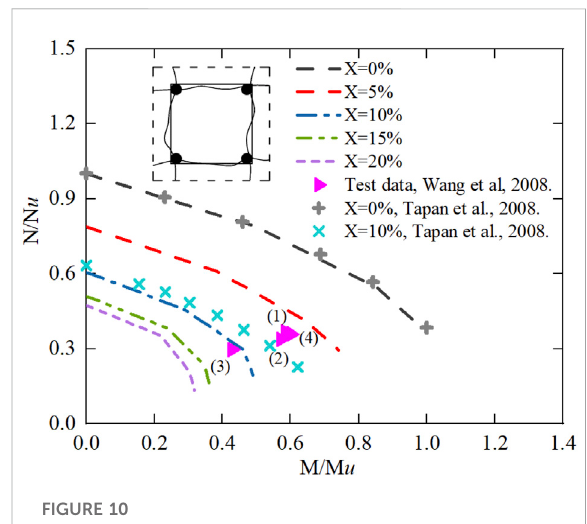
FIGURE 10 M-N interaction diagram for the corroded RC column at various corrosion